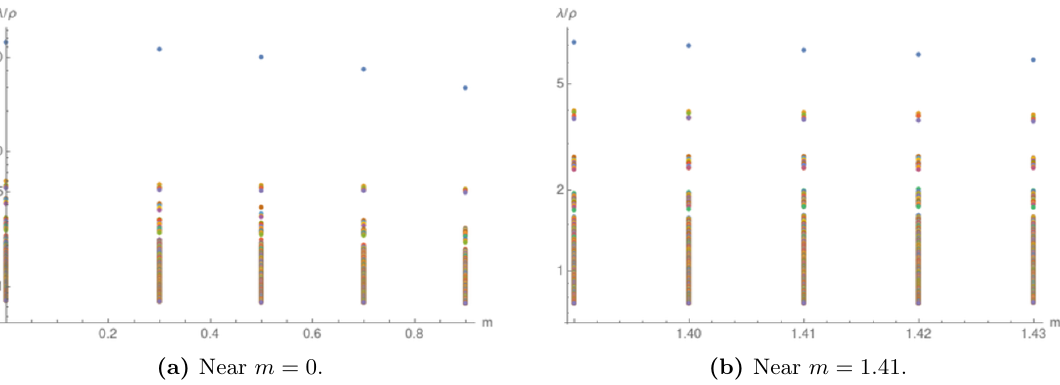
Figure 20. Log-linear plot of the (cid:12)rst 500 positive eigenvalues of i (cid:1) at T = 1 : 42 ; (cid:26) = 9, in 4d de Sitter.